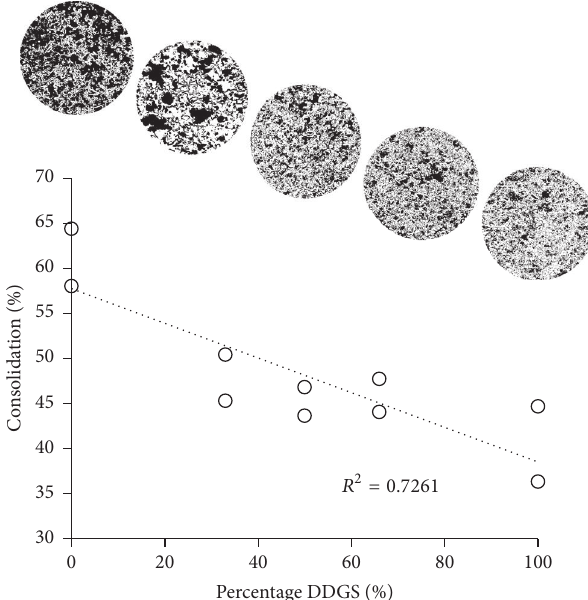
Figure 9: Percentage consolidation as a function of DDGS content.